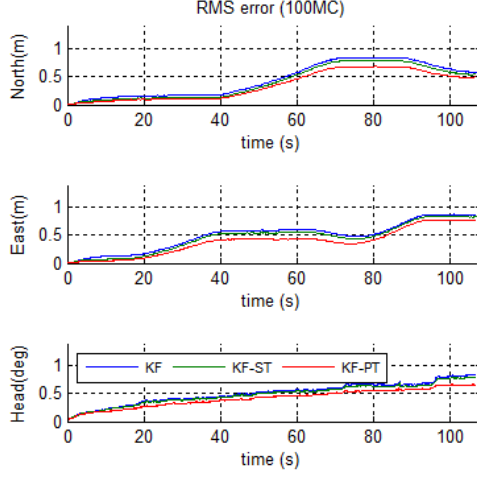
Figure 4 2D VO measurement noise and number of features Monte Carlo (MC) simulations were used to compare the performance of the three implemented Kalman filters. Each algorithm was run 100 times. The true position and heading errors were computed for each run. Then the root-mean-square (RMS) errors across the 100 runs were computed at every epoch. The resulting error bounds were then compared with the estimated standard deviations. The figures 5 shows the true pose RMS errors computed in (a) KF (b) KF-ST and (c) the proposed KF-PT. Clearly the true KF-PT errors are smaller than the ones from KF and KF-ST.